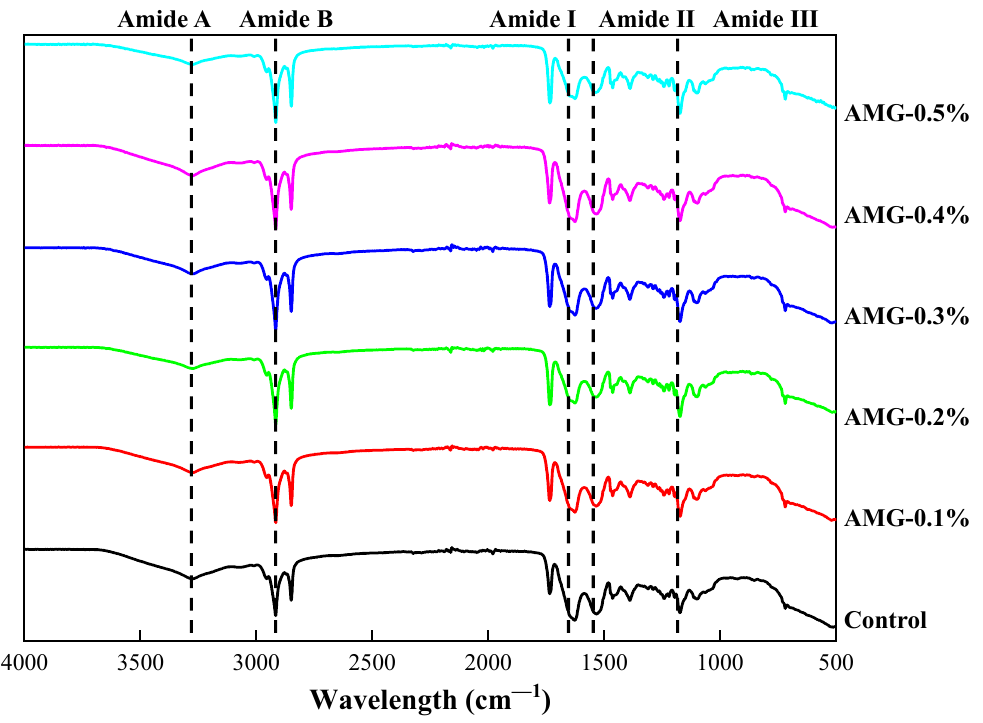
Figure 2. Infrared spectrogram of frankfurters with or without AMG at different concentrations. Control: no added AMG; AMG-0.1%: 0.1% added AMG; AMG-0.2%: 0.2% added AMG; AMG-0.3%: 0.3% added AMG; AMG-0.4%: 0.4% added AMG; and AMG-0.5%: 0.5% added AMG. Table 5. The percentages (%) of the protein secondary structure of frankfurters with or without AMG at different concentrations.